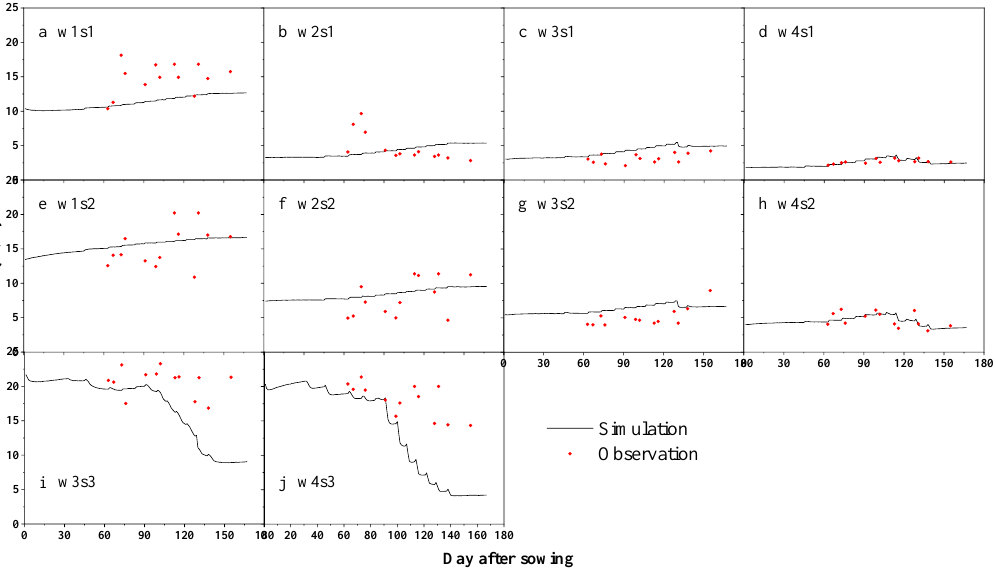
Figure 10. Comparison between observed and simulated average ECe in the 0 – 80 cm soil profile for different irrigation and salinity treatments (a-j). (The dots represent the measured data, the lines represent the simulated values. W1, W2, W3 and W4 represent irrigation amount of 22.5, 30, 37.5 and 45 mm. S1, S2 and S3 represent the soil salinity of 0.2%, 0.4% and 0.6%.)